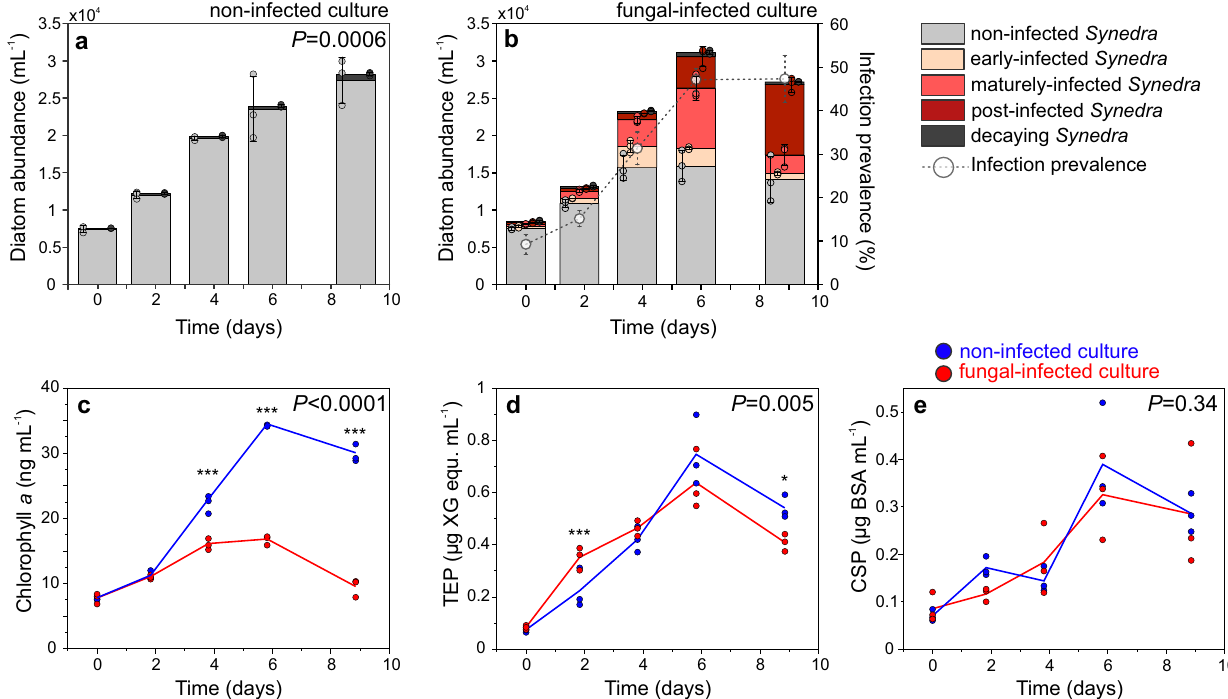
Fig. 2 Characteristics of the diatom co-culture in the absence or presence of the fungal microparasite. Diatom abundances and infection prevalence in the non-infected ( a ) and fungal-infected culture ( b ), c chlorophyll a , as well as d TEP and e CSP concentrations, monitored over nine days. Stacked bars a , b display mean values (bar height) with triplicate data points (circles) and standard deviations (error bars). Data in c – e are shown as single data points, while lines connect mean values for consecutive time points (symbols for mean values are not displayed). P -values, shown in the upper right corner of each graph, indicate statistically signi fi cant differences between the entire time series of each parameter in both treatments (GLMM). Statistically signi fi cant differences between treatments at single time points are indicated with asterisks ( * P < 0.05, *** P < 0.001). a – e N = 3 incubation fl asks. c – e Blue and red items represent data from the non-infected and infected cultures, respectively. TEP Transparent Exopolymer Particles, CSP Coomassie Blue Stainable Particles, XG equ. Xanthan Gum equivalents, BSA equ. Bovine Serum Albumin equivalents. ( P > 0.05, t -test, N = 3 fl asks) but signi fi cantly lower chlorophyll a and 34 ± 3 µmol L − 1 , P = 0.32; and dissolved organic carbon: contents in the infected vs . non-infected cultures during day 4 – 9 332 ± 24 and 299 ± 11 µmol L − 1 in the non-infected and infected treatment, respectively, P = 0.12, t -test, N = 3 fl asks). ( e.g ., day 9: 9.5 ± 1.2 and 30.1 ± 1.7 ng chl a mL − 1 , respectively, P < 0.001, t -test, N = 3 fl asks, Fig. 2c). Nutrient concentrations (analyzed at the end of the incubations on day 9) were similar in Extracellular polymers (model system, culturing) . Transparent both culture treatments (NO 3 − + NO 2 − : 225 ± 2 and 243 ± 9 µmol L − 1 , P = 0.07; soluble reactive phosphorous: 31 ± 2 COMMUNICATIONS BIOLOGY| (2023) 6:206